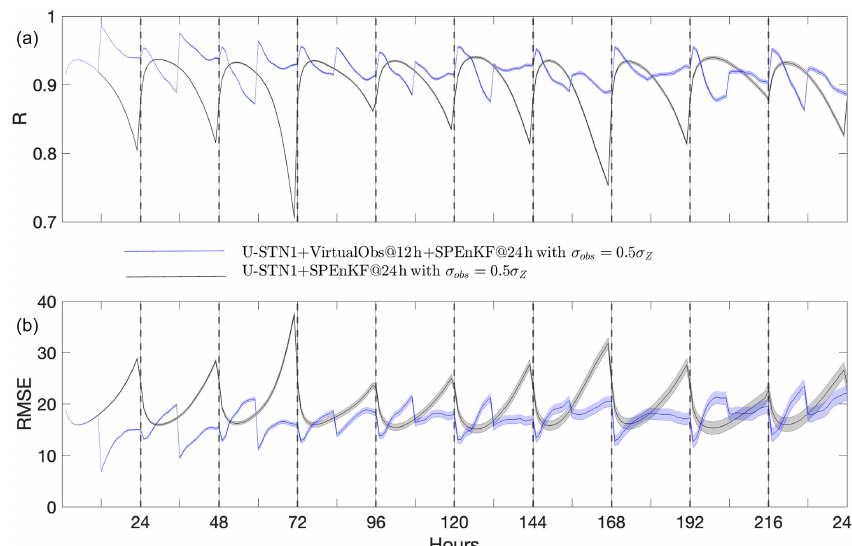
Figure 8. Performance of the multi-time-step U-STNx+SPEnKF framework (with virtual observations at the 12th hour of every 24h DA cycle) compared to that of the U-STN+SPEnKF framework for the case with σ obs = 0 . 5 σ Z . Panels (a) and (b) show R (RMSE in meters). The black, dashed vertical lines indicate DA of noisy observations at every 24h. Forecasts are started from 30 random, noisy initial conditions. The lines (shading) show the mean (standard deviation) of the 30 forecasts.